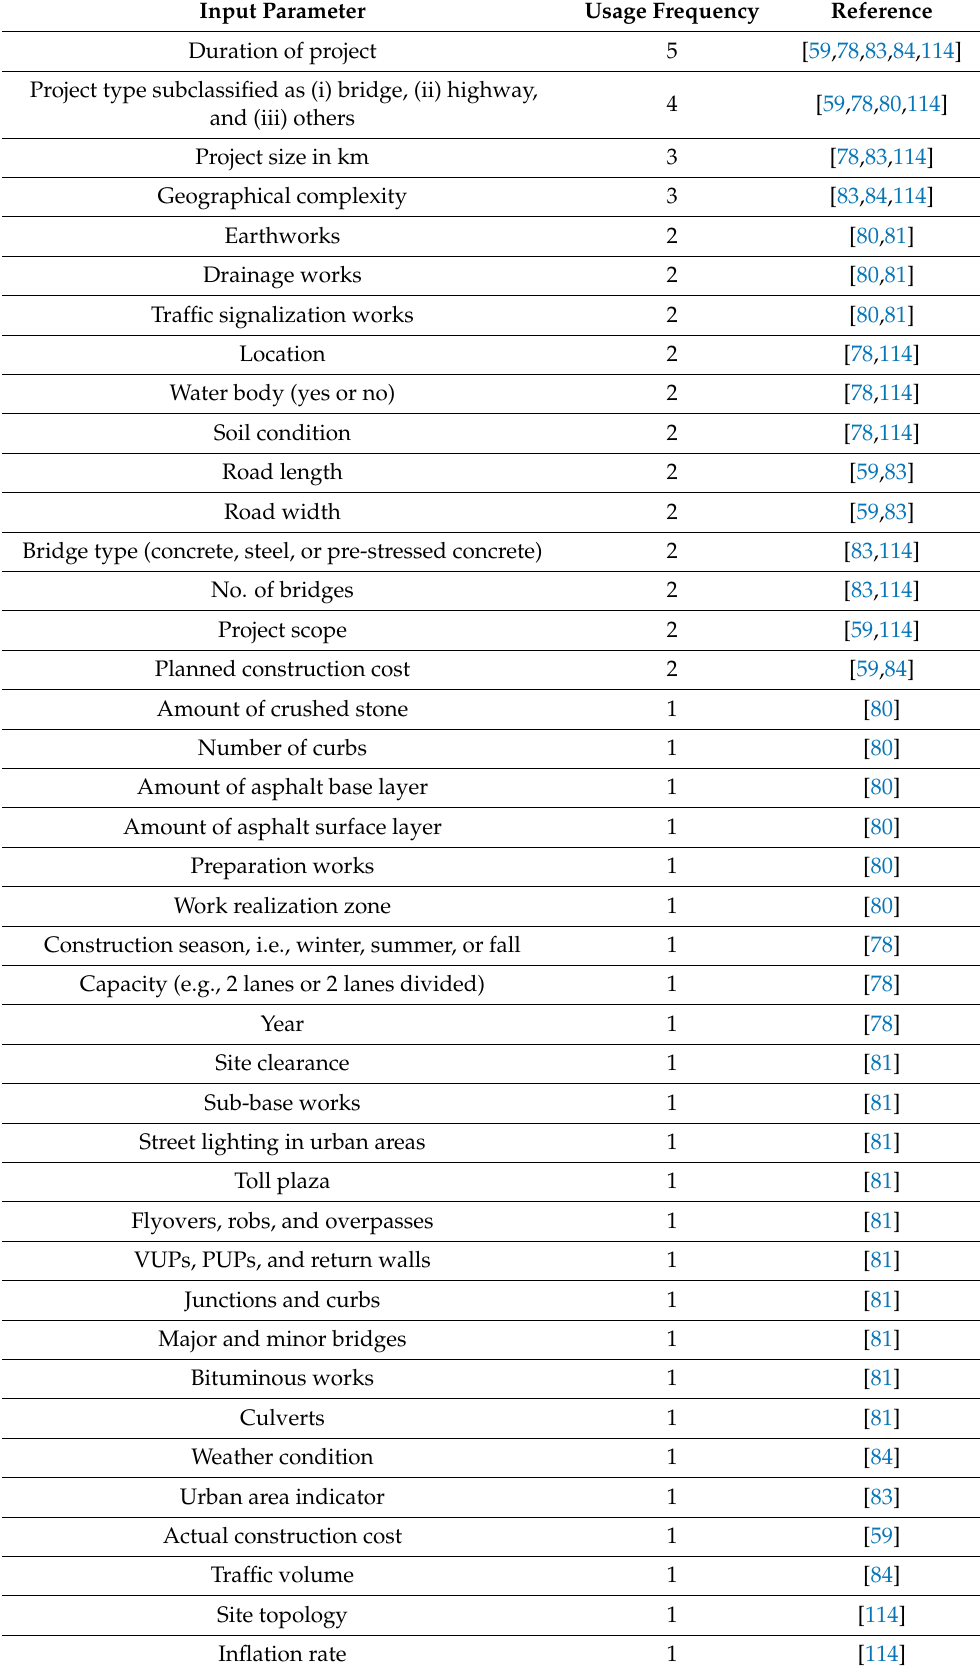
Table 6. List of input parameters deciding the construction cost of a road